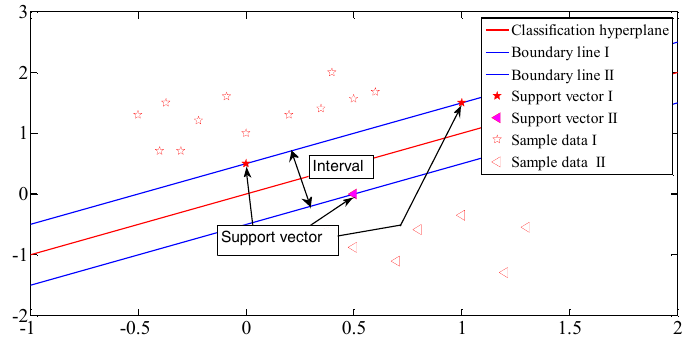
Figure 2. Support vector machine classification schematic diagram.